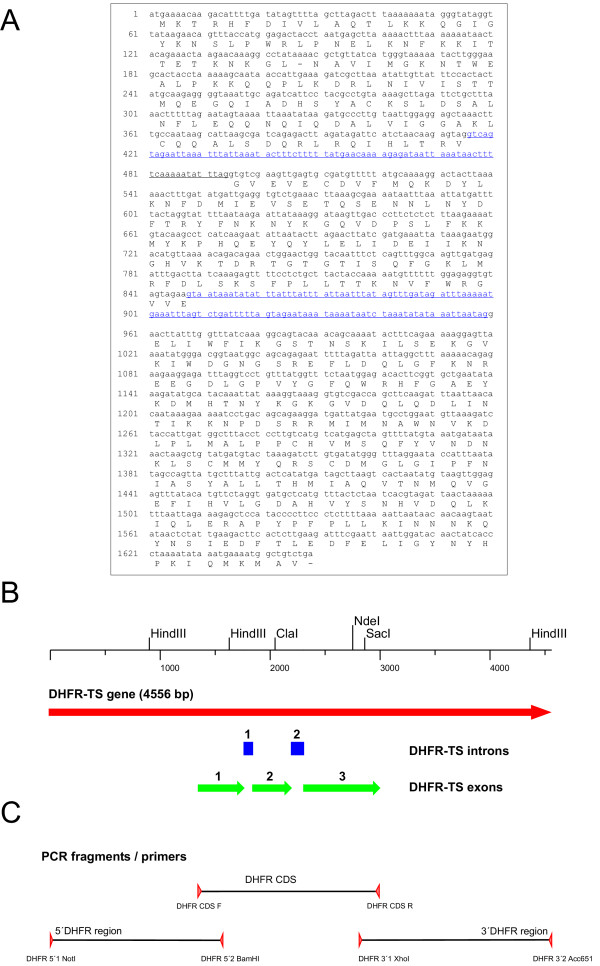
Genomic structure of T. thermophila bifunctional DHFR-TS enzyme. A: The DNA sequences of the gene and the cDNA as well as the deduced amino acid sequence are shown on the left (introns underlined, blue). B: The DHFR-TS gene structure of T. thermophila consists of three exons (green) and two introns (blue). C:Overview of primer pairs to amplify DNA for homologous integration and to amplify the CDS.